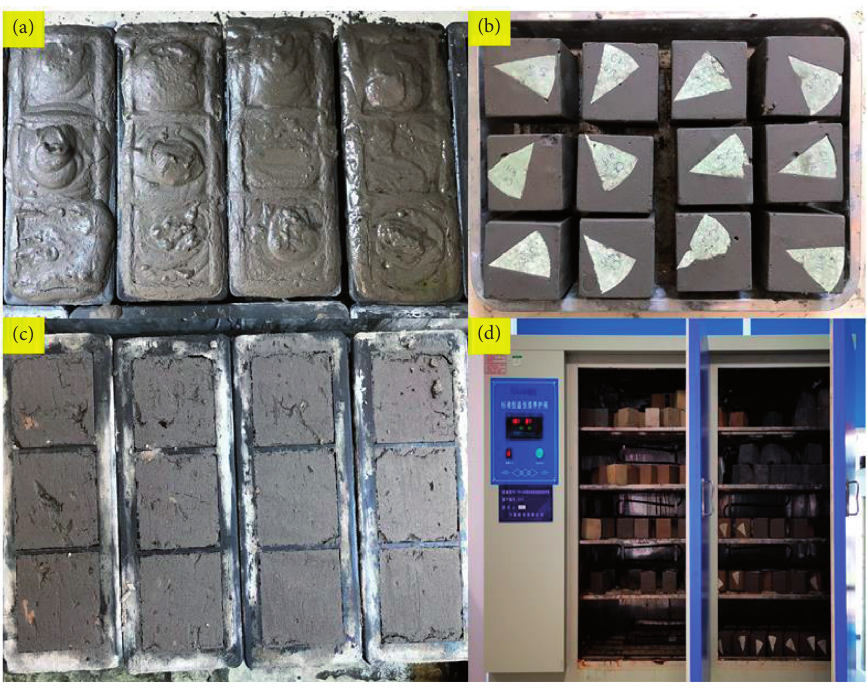
Figure 5: CPB specimens preparation and curing process.